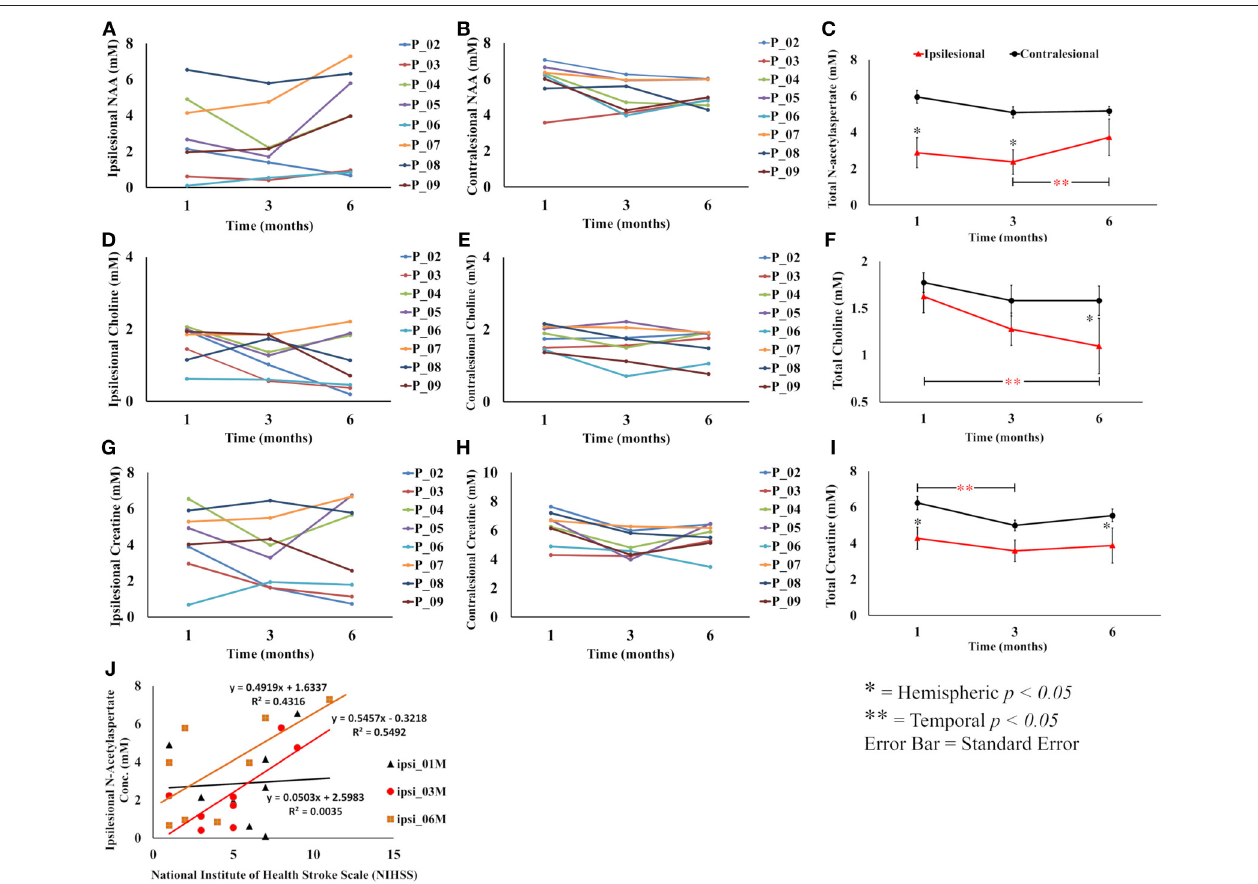
FIGURE 2 | Overall summary of post treatment serial change in metabolite concentration in the lesion and contralesion voxels. (A,B) Show serial ipsilesional and contralesional NAA concentrations in individual participants, respectively. (C) Shows overall trend of significant hemispheric decrease of NAA concentration between 1 and 3 months. Temporally, ipsilesional NAA increased between 3 and 6 months. (D,E) Show serial ipsilesional and contralesional choline concentrations in individual participants, respectively. (F) Shows an overall significant continual decline of ipsilesional choline concentration between 1 and 6 months, whereas in the contralesion it decreased between 1 and 3 months and then stabilized between 3 and 6 months. (G,H) Show serial ipsilesional and contralesional creatine concentrations in individual participants, respectively. (I) Illustrates the overall hemispheric and temporal decrease of creatine concentration between 1 and 3 months that stabilized between 3 and 6 months. A correlation between ipsilesional NAA concentration and NIHSS at 1, 3, and 6 months is shown in (J) . A significant ( p < 0.03) correlation was observed at 3